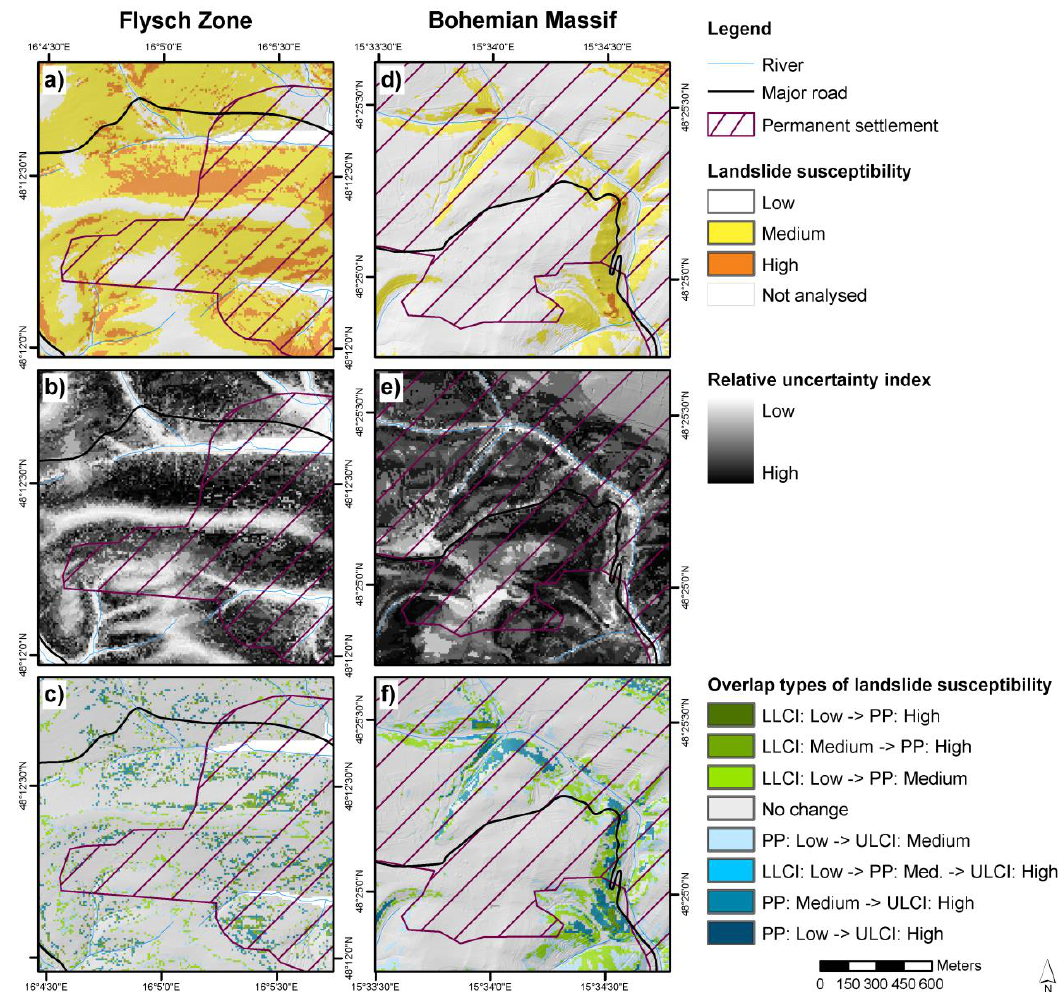
Fig. 8. Landslide susceptibility map (target scale 1:25000) and map uncertainty in an example area. (a) , (d) Susceptibility map; (b) , (e) relative uncertainty index; (c) , (f) susceptibility class uncertainty. Panels (a–c) correspond to an area in the Flysch Zone (very high landslide density), (d–f) are in the Bohemian Massif (very low landslide density). The susceptibility class uncertainty refers to differences between Figure 8. Landslide susceptibility map (target scale 1:25,000) and map uncertainty in an 3 susceptibility maps at the lower confidence limit (LLCI) or the upper confidence limit (ULCI) at the 95% confidence level relative to the class in the predicted probability map (PP) in panels (a) and (d) . Data sources: LiDAR-DTM hillshade, river, major road and settlement – Provincial Government of Lower